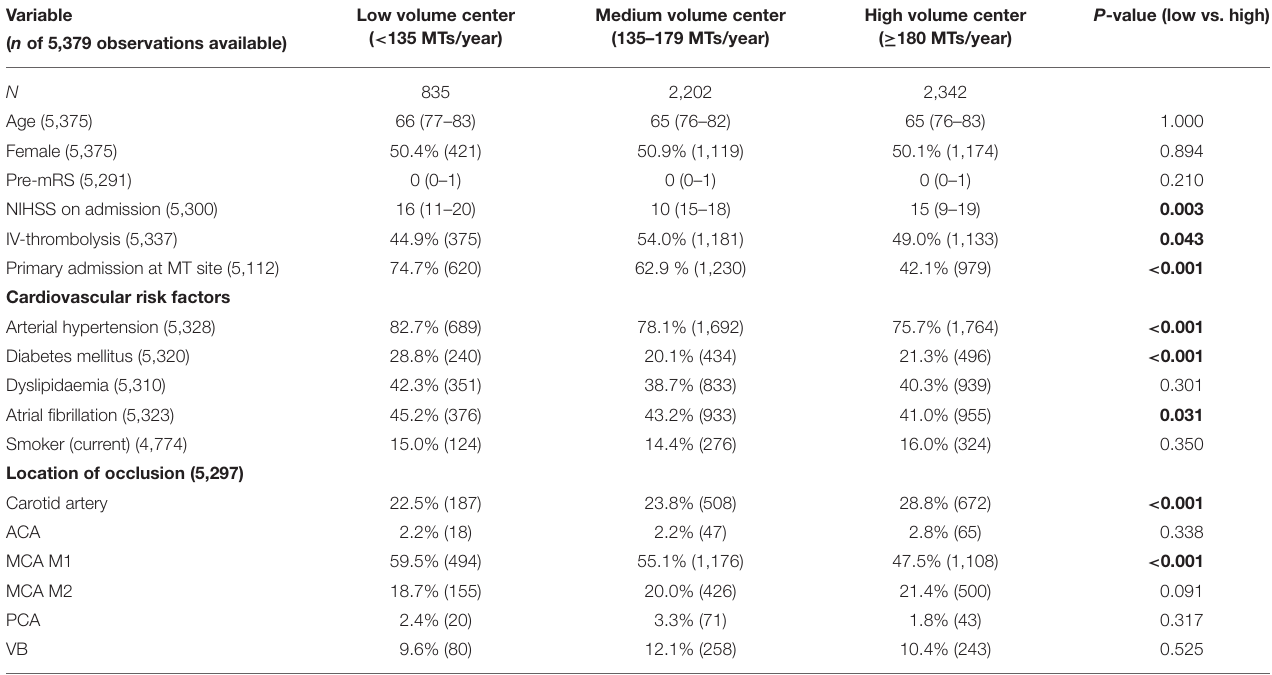
TABLE 1 | Baseline characteristics of